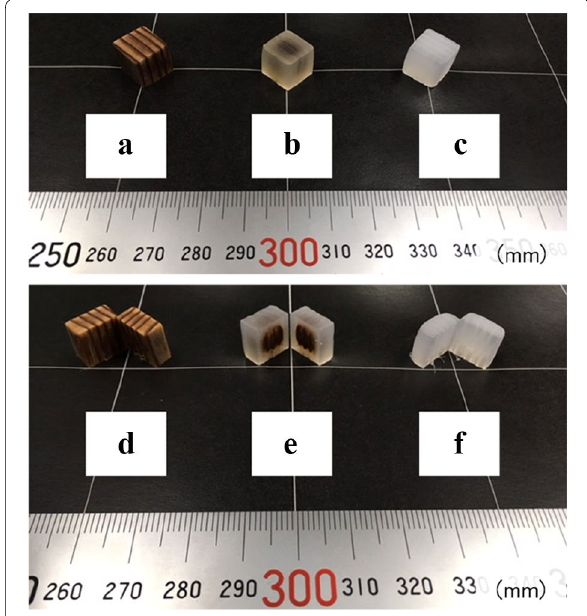
Fig. 4 Wood blocks ( a ) after alcoholysis, ( b ) bleaching 4 times and ( c ) bleaching 8 times. d – f The wood blocks corresponding to ( a – c ) those were longitudinally cut along the radial direction to observe the inner region